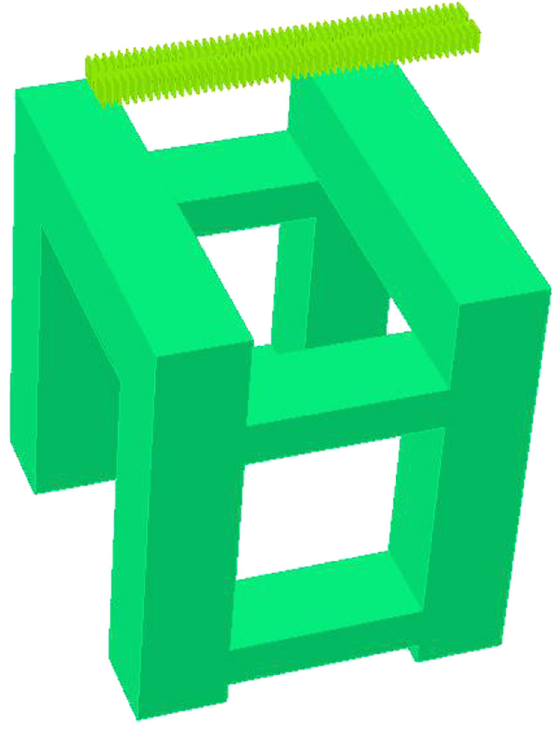
FIG. 14. Simulation model of the horizontal device with stand (UNA33 with 33-mm period magnetic